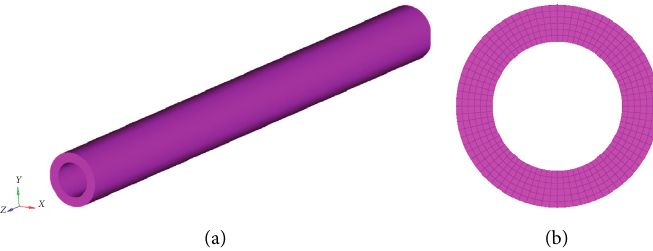
Figure 8: Meshing diagram of the aluminum pipe: (a) overall view; (b) cross-sectional view.